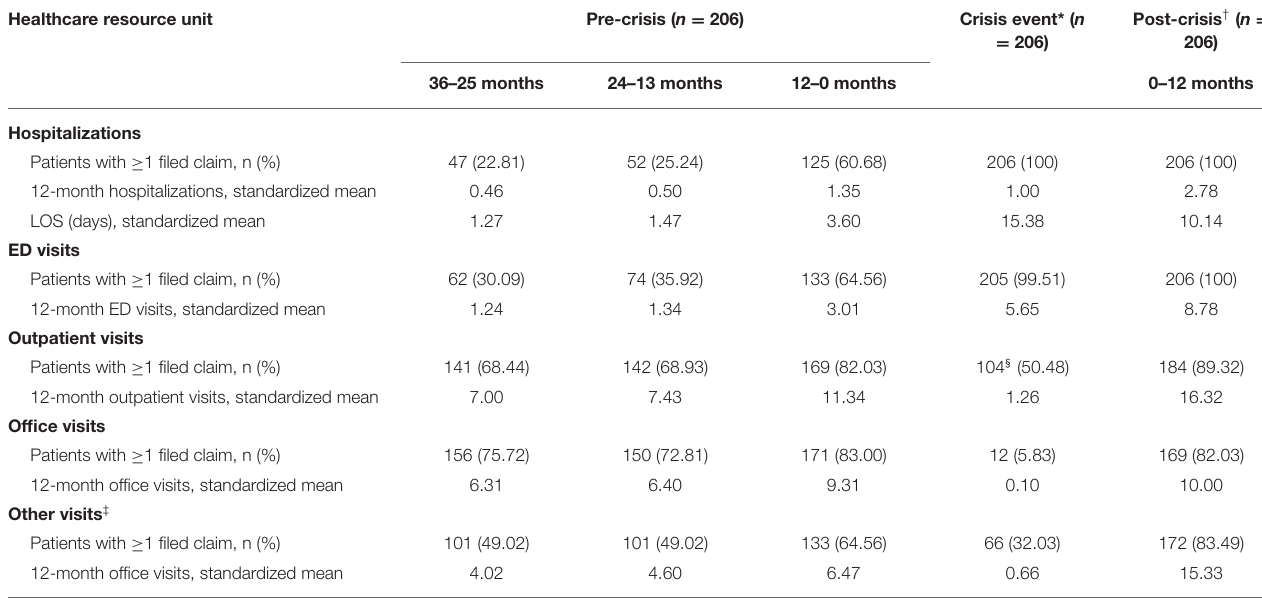
TABLE 3 | Standardized healthcare resource utilization in the crisis event subgroup. Healthcare resource